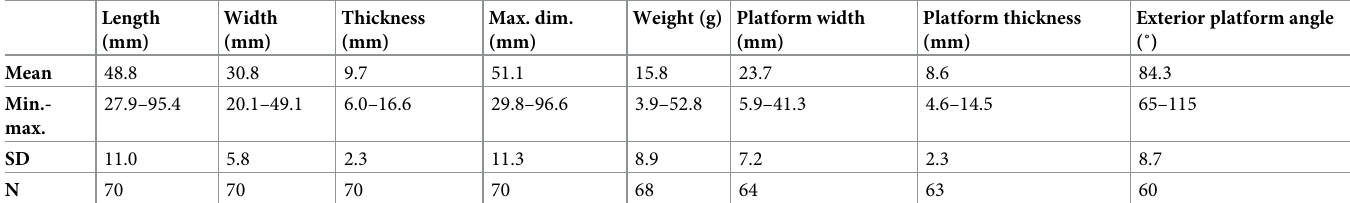
Table 13. Summary of descriptive statistics for Tweefontein complete points. Length (mm)